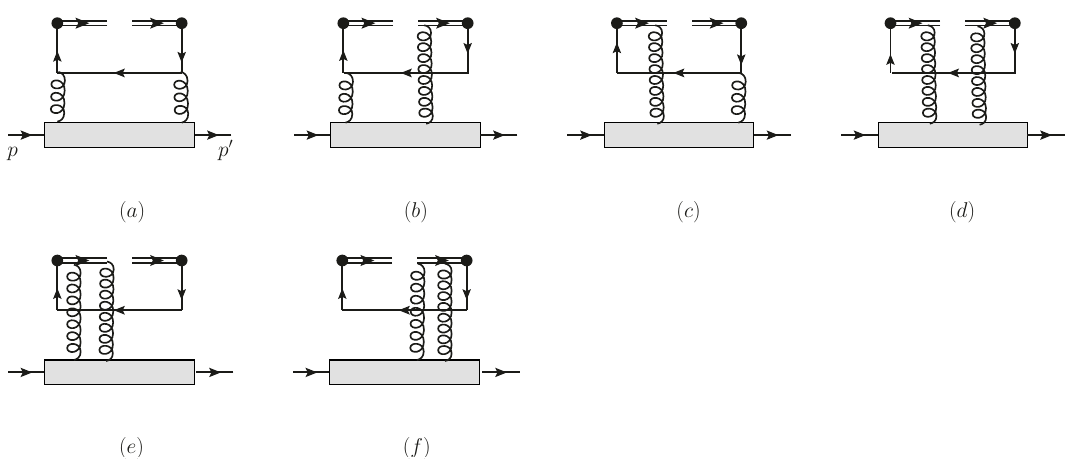
Figure 3 . The one-loop diagrams for quark quasi-GPDs. These diagrams represent contributions from gluon